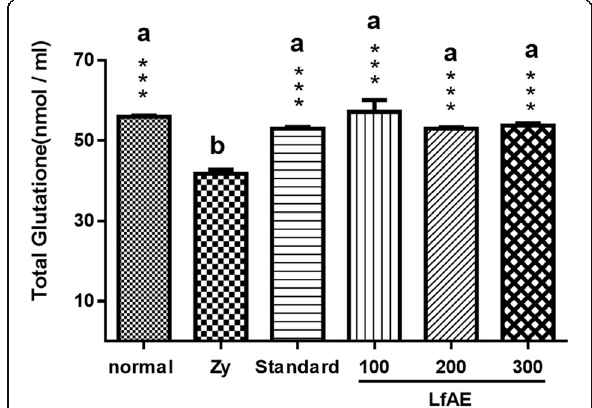
Fig. 4 Effect of LfAE (100, 200 and 300 mg/kg) on total glutathione levels in the zymosan-induced arthritis model. Data are expressed as mean ± SD (One-way ANOVA, Tukey-Kramer test, n = 6 per group). Letters ( a , b ) refer to the result of Tukey-Kramer post hoc